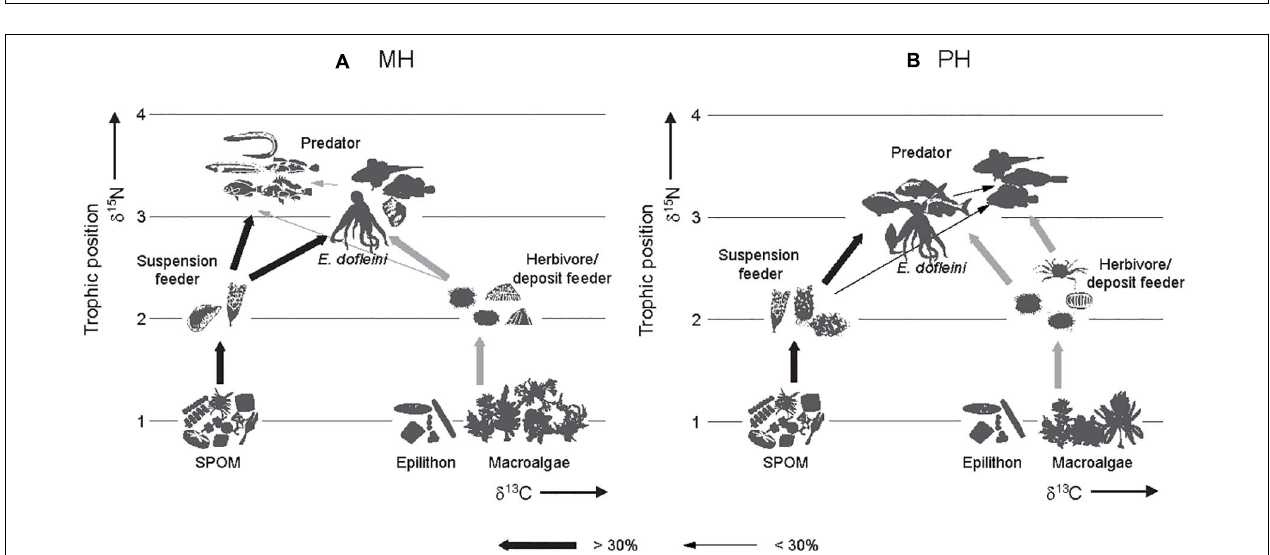
FIGURE 7 | Conceptual food-web models generated for two marine ranching ecosystems of the MH (A) and PH (B) sites. Arrows show direction of trophic transfer. The thickness of the lines indicates the percentage contribution of a prey to the diet of its predator. Despite spatial variations in community composition, trophic connections and food-web pathways of the giant octopus Enteroctopus dofleini remain unchanged in two marine ranching systems. SPOM represents suspended particulate organic